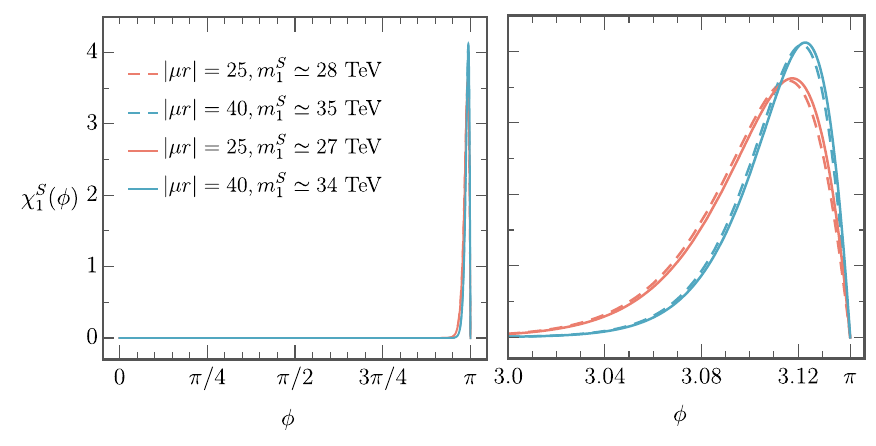
Figure 8 . Pro(cid:12)les of the (cid:12)rst KK resonance of the bulk scalar (cid:12)eld for (blue), for strong (solid lines) and no (dashed lines) backreaction on the metric for (cid:13) = 0 : 5. The di(cid:11)erent mass eigenvalues are shown in the legend. In all cases we have (cid:12)xed m g